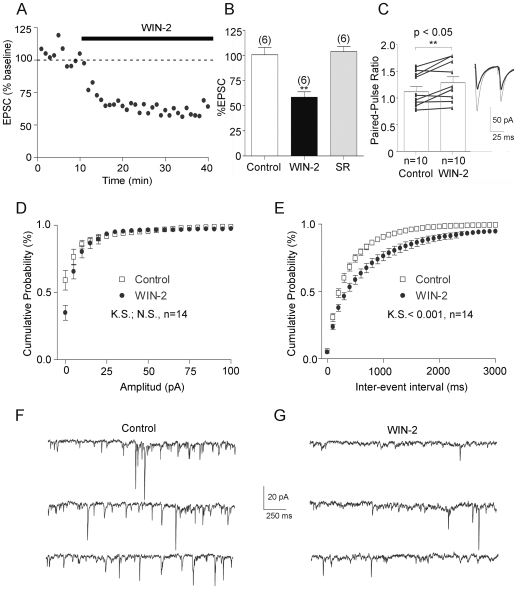
CB1 inhibits glutamatergic synapses in the anterolateral BNST at a presynaptic locus.A, time course of 1 µM WIN-2-induced inhibition of evoked EPSC normalized to baseline. B, Summary of all experiments performed as described in A: EPSC was 100.6±7.355% (n = 6) of baseline in control, 58.46±5.406% (n = 6; p = 0.03 t test *: p<0.05) at 60 min after WIN-2 and 103.7±5.230% (n = 6; p = 0.8483; ns: p>0.05) at 120 min after co-perfusion with SR C left, paired-pulse ratio were augmented during WIN-2 perfusion (n = 10; paired t test p = 0.0065; **: p<0.05). PPR was calculated with 60 sweeps i.e. 10 min before and 20 min after WIN-2.; right, representative EPSC traces from an alBNST neuron before and after WIN-2 application, average of 30 consecutive traces. Observe that the inhibition of the first EPSC by WIN-2 is larger than the second one. Calibration bars: x: 25 ms, y: 50 pA. D, bath perfusion of WIN-2 did not change the distribution of sEPSCs amplitude (n = 14). E, the distribution of the time intervals between successive sEPSCs in these neurons revealed that the sEPSCs frequency was reduced during WIN-2 application. (Kolmogorov-Smirnov test p<0.0001). Representative consecutive 2-sec current sweeps from a cell where sEPSCs were recorded in control (F) and 30 min after the start of the WIN-2 application (G). Calibration bars: x: 250 ms, y: 20 pA.